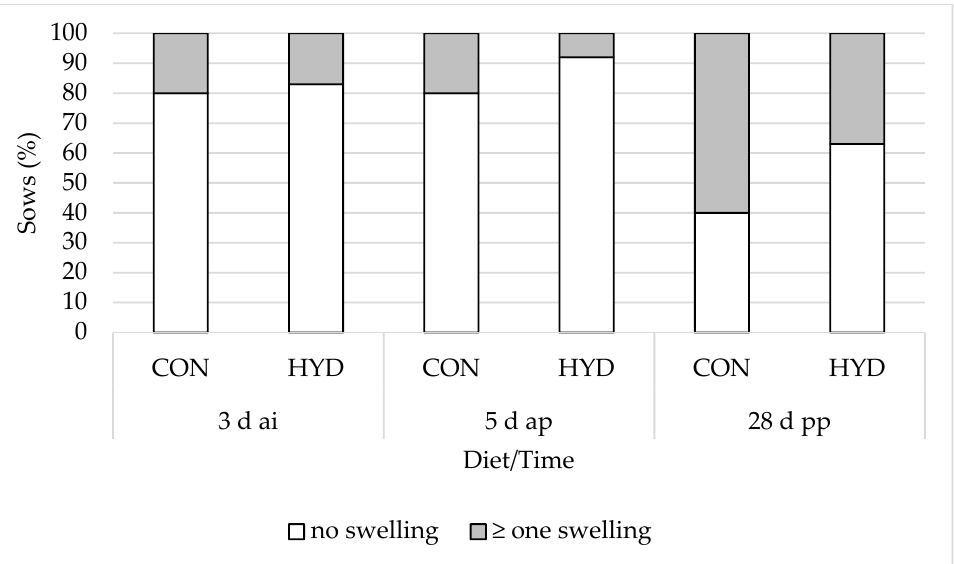
Figure 3. Effect of dietary vitamin D source on prevalence (%) of leg swelling (carpal/tarsal joints) of sows. CON, 50 μ g/kg vitamin D 3 ( n = 25); HYD, 50 μ g/kg 25-OHD 3 ( n = 24).